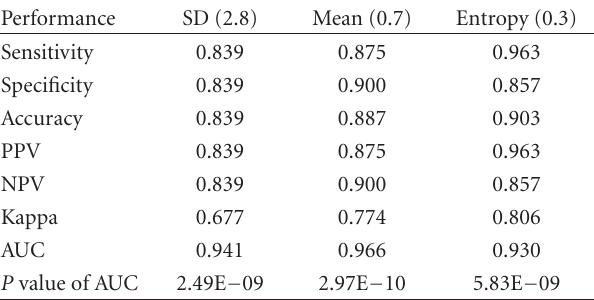
Table 3: The sensitivity, specificity, accuracy, PPV, NPV, kappa statistics, AUC, and P value of AUC are listed for QV of 2.8, 0.7, and 0.3 with respective to SD, mean, and entropy of pixel intensity in the